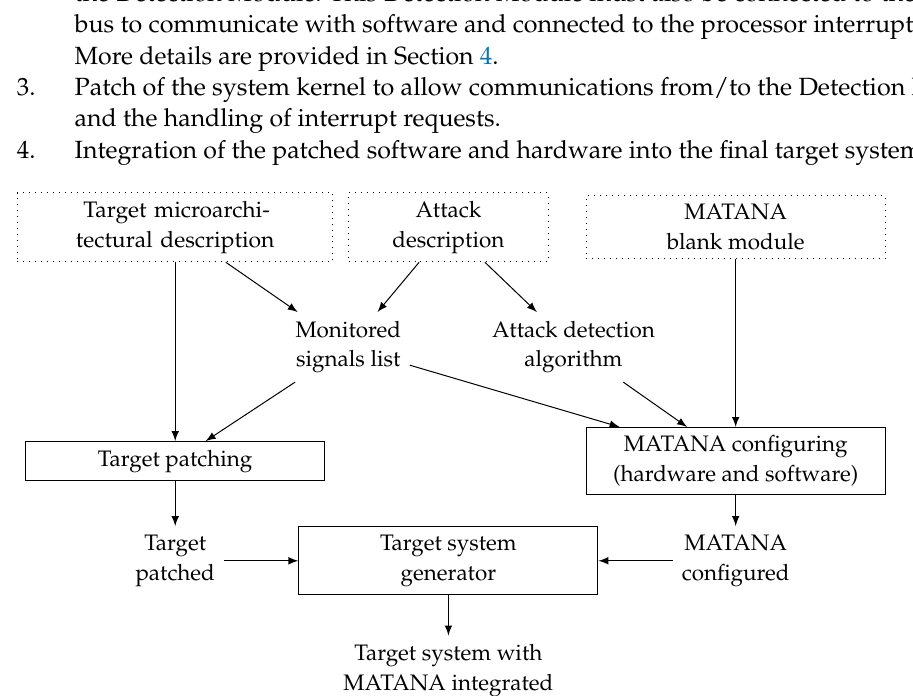
Figure 1. Design flow for integrating MATANA into a target